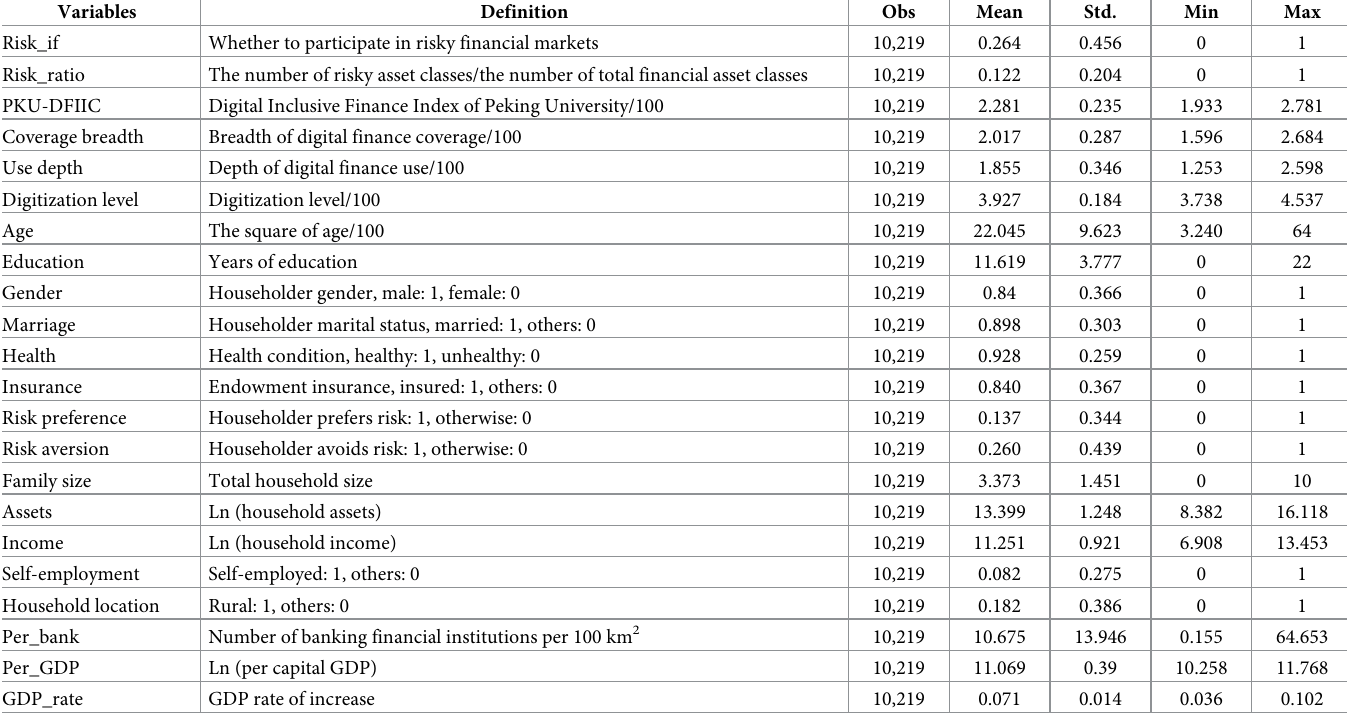
Table 1. Variable definition and descriptive